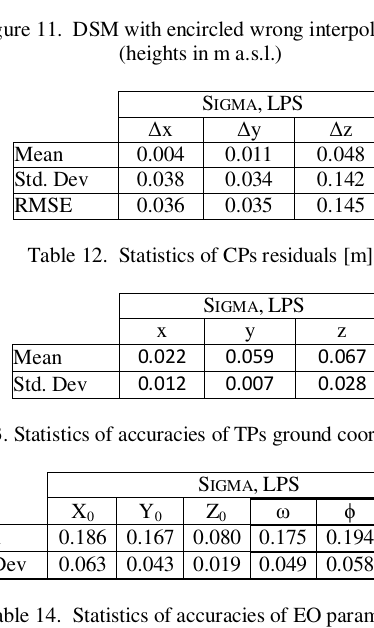
Table 14. Statistics of accuracies of EO parameters (lengths in meters, angles in degrees)